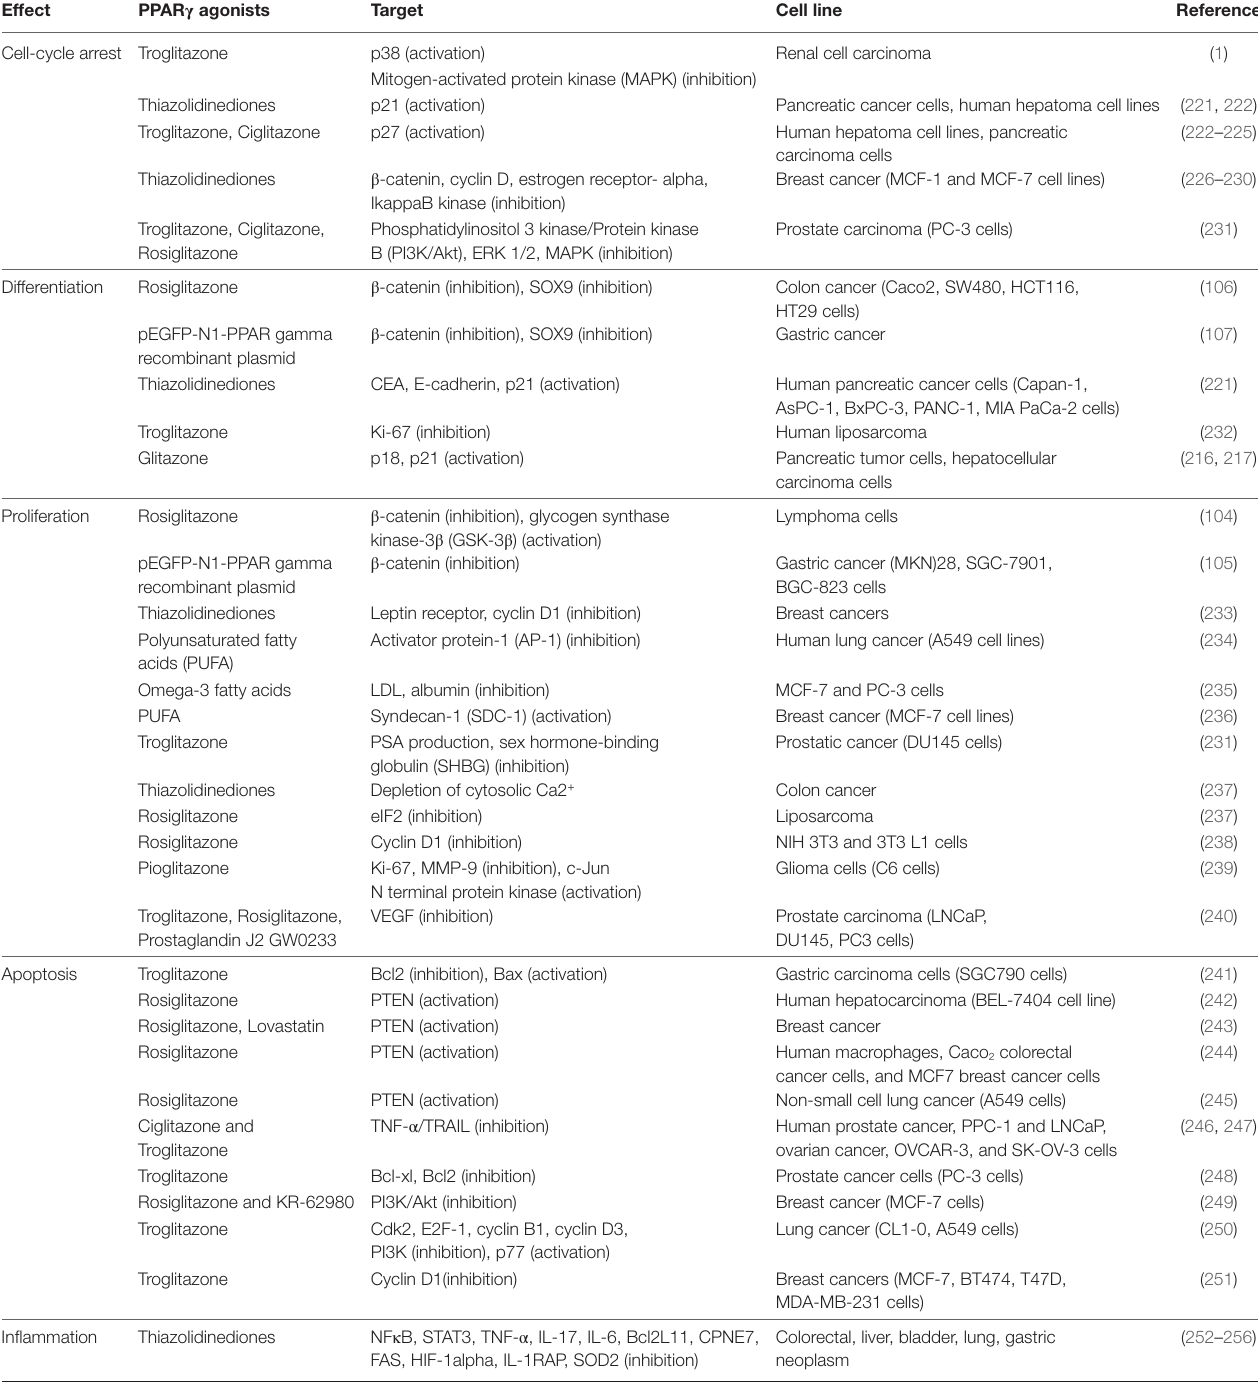
breast, prostate, and colon cancers (216, 217). NCOR, a repressor of PPAR γ , has been found to increase in prostate cancer and to inhibit the expression of PPAR γ (218). Several mutations of PPAR γ are correlated with cancer initiation (219, 220). PPAR TABLe 1 | Anti-tumoral effects of peroxisome proliferator-activated receptor gamma (PPAR γ ) agonists. effect